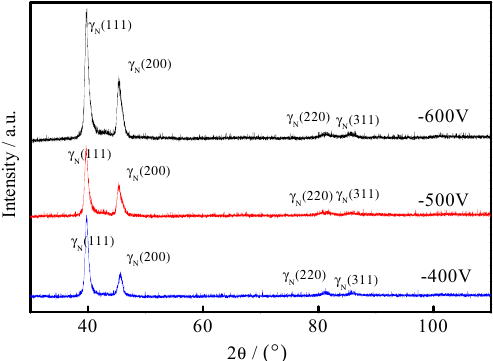
Figure 1. X-ray di ff raction (XRD) patterns of the plasma-nitrided coating under di ff erent bias Figure 1. X-ray diffraction (XRD) patterns of the plasma-nitrided coating under different bias voltages.